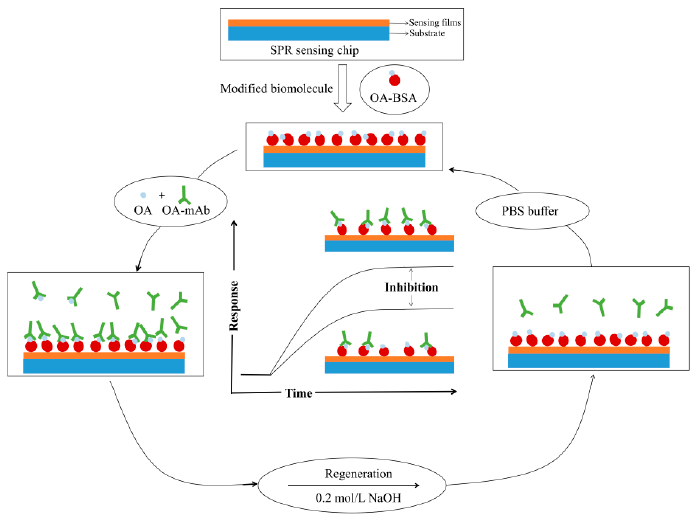
Figure 13. The schematic diagram of the detection process for OA.